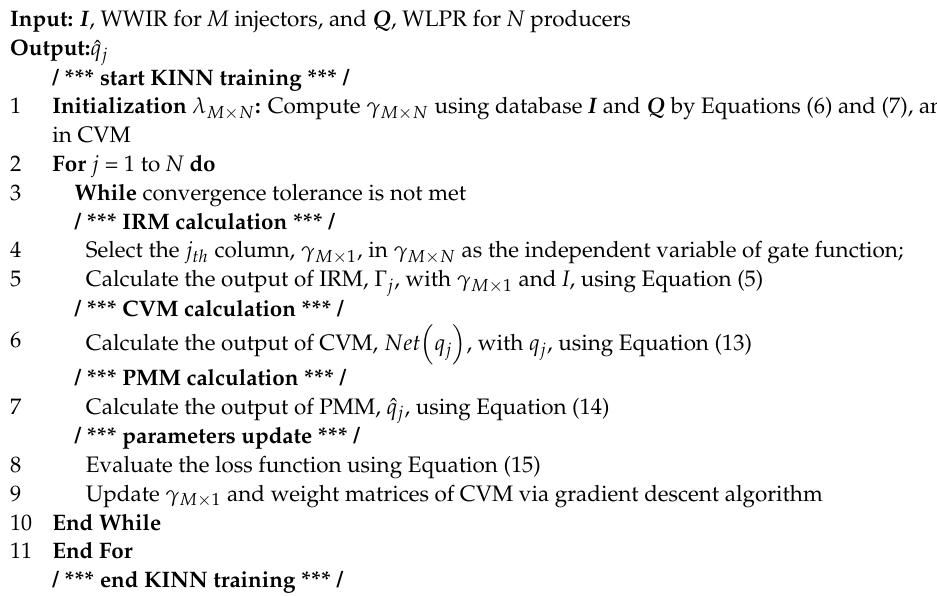
Algorithm 1: Knowledge Interaction Neural Network